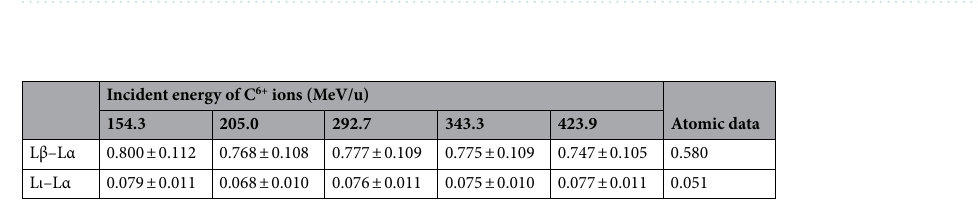
Table 1. Au L-subshell x-ray energies induced by high energy C 6+ ions and 300 keV H + , and the atomic data 38,39 .